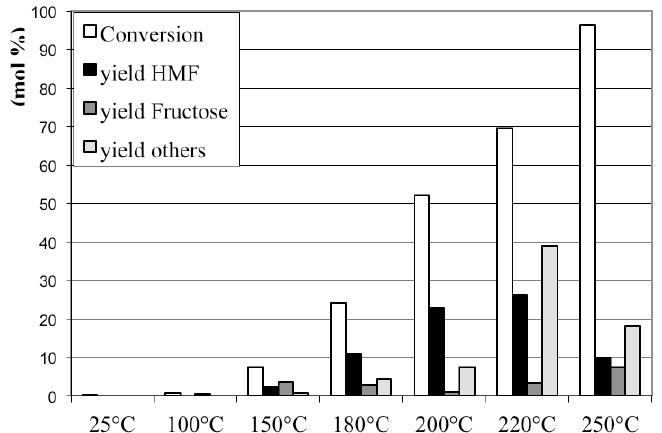
Conditions: batch, 1%wt glucose in water, without catalyst: reaction time 2